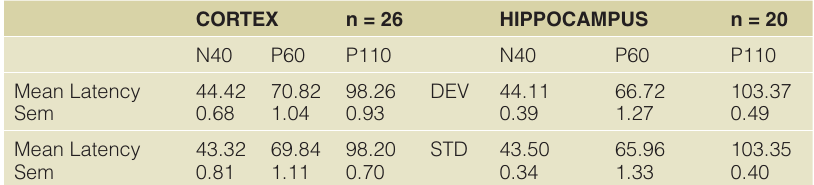
Table 1. Latencies for defined mid-latency components in [ms] (combined three days of Experiment